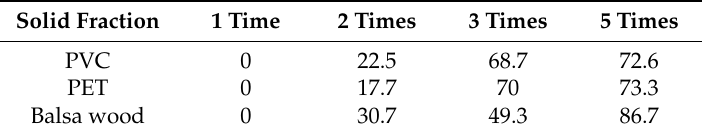
Table 3. Glass transition scale reduction (%) with θ .